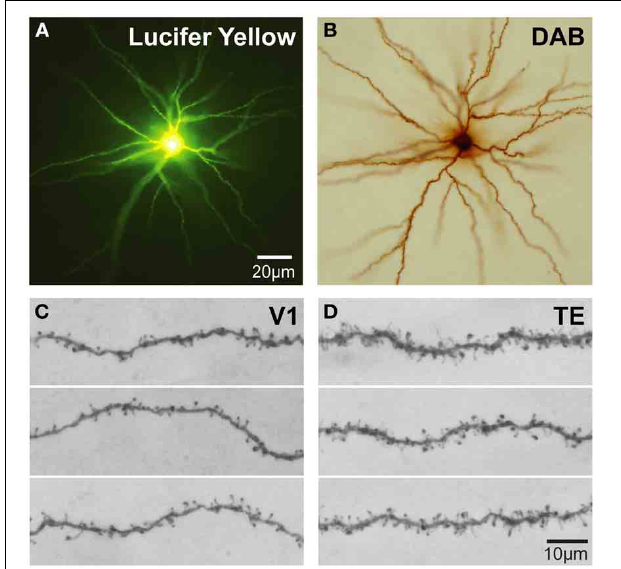
FIGURE 4 | Cell injection. (A) Low power photomicrographs of Lucifer Yellow-injected layer III pyramidal cells that were injected in tangential sections taken from the granular prefrontal cortex of the macaque monkey (area 12vl) and processed for a DAB reaction product. (B) (C,D) Higher power photos of primary visual (V1) and inferotemporal (TE) cortical cells as viewed through a × 100 oil-immersion Zeiss objective, revealing aspects of their fine structure including dendritic spines. Scale bar = 20 μ m in (A,B) and 10 μ m in (C,D)